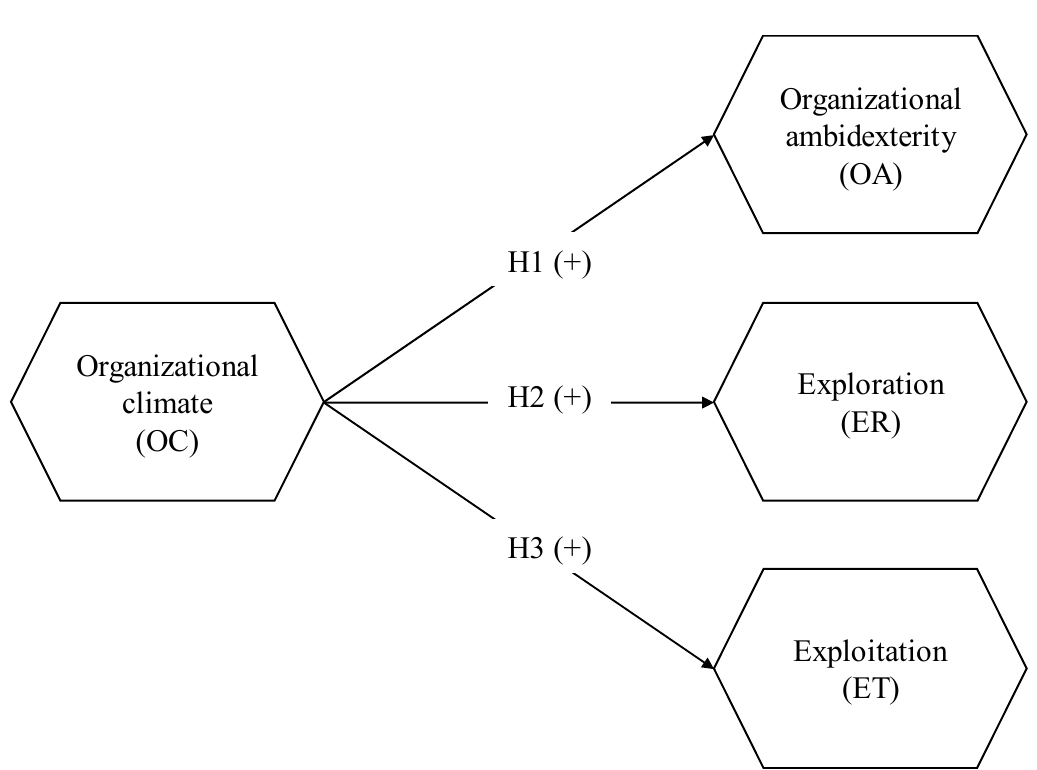
Figure 1. Research model and hypotheses. OC = Organizational climate; OA = Organizational ambidexterity; ER = Exploration; ET = Exploitation.